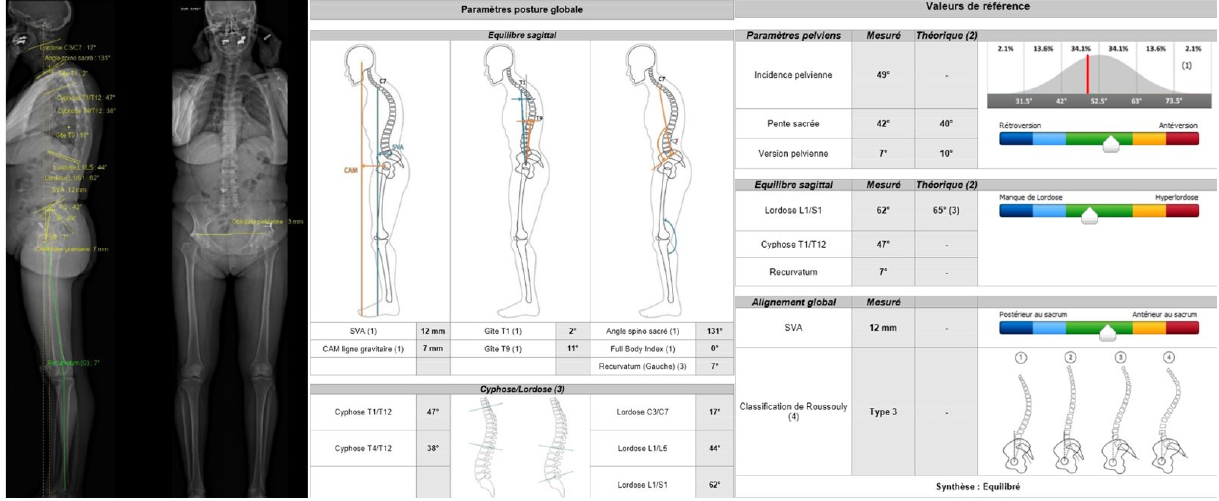
Figure 8. EOS ® imaging example showing spine parameters and their relationship with pelvic parameters. Spinal kyphosis and lordosis angles are provided along with the sagittal vertical axis measurement, as well as pelvic parameters, to provide a global appreciation of the spinopelvic com ‐ plex, considered well balanced in this example.